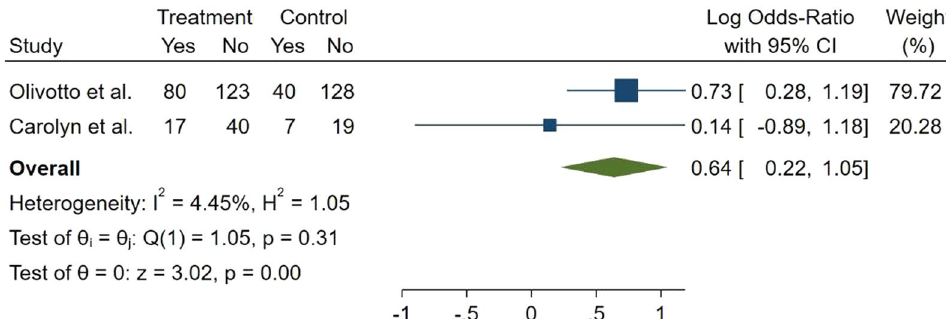
one reduction in NYHA function ≥